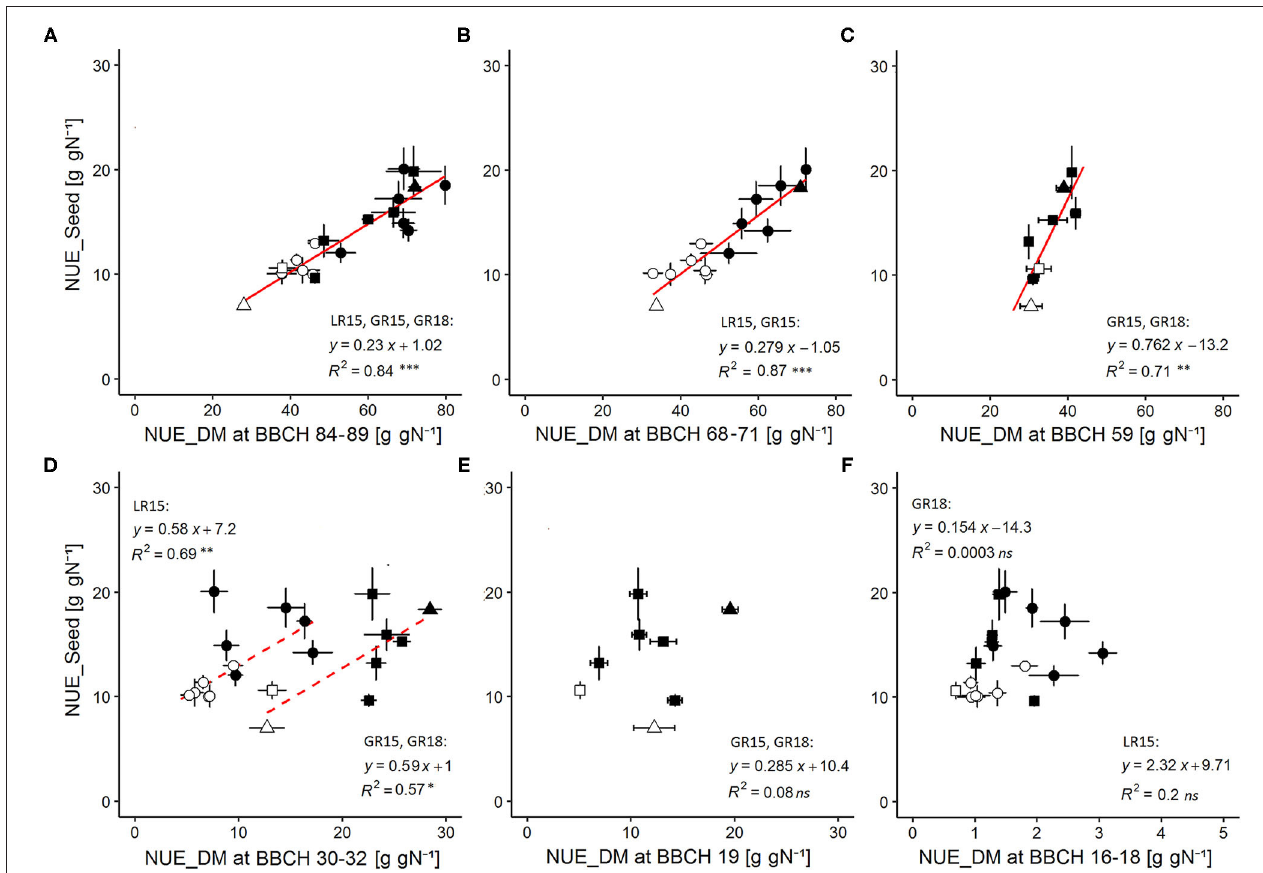
FIGURE 2 | Relationships between NUE_Seed measured at seed maturity (BBCH 84-89) and NUE_DM throughout the crop cycle. NUE_DM was measured at (A) seed maturity (BBCH 84-89), (B) end of flowering (BBCH 68-71), (C) just before flower opening (BBCH 59), (D) beginning of stem elongation after winter (BBCH 30-32), (E) mid rosette development (BBCH 19), and (F) early rosette development (BBCH 16-18). Regressions were performed by pooling data for all sites × years × N conditions when no significant differences on relationships parameters were found by separately comparing site, year or N condition effects. Solid lines indicate significant regressions ( P- value < 0.05) validated both for each N condition separately as well as by pooling N conditions. Dashed lines indicate significant regression ( P- value < 0.05) valid only when grouping N conditions. Open symbols correspond to the high-N condition, while filled symbols correspond to the low-N condition, with circles for LR15, triangles for GR15, and squares for GR18. Error bars depict standard errors of the mean of each genotype with n = 5 and 6 at each sampling date and for each N condition in LR15 and GR15, respectively, and n = 6 and 7–8 at each sampling date for high and low N-conditions respectively in